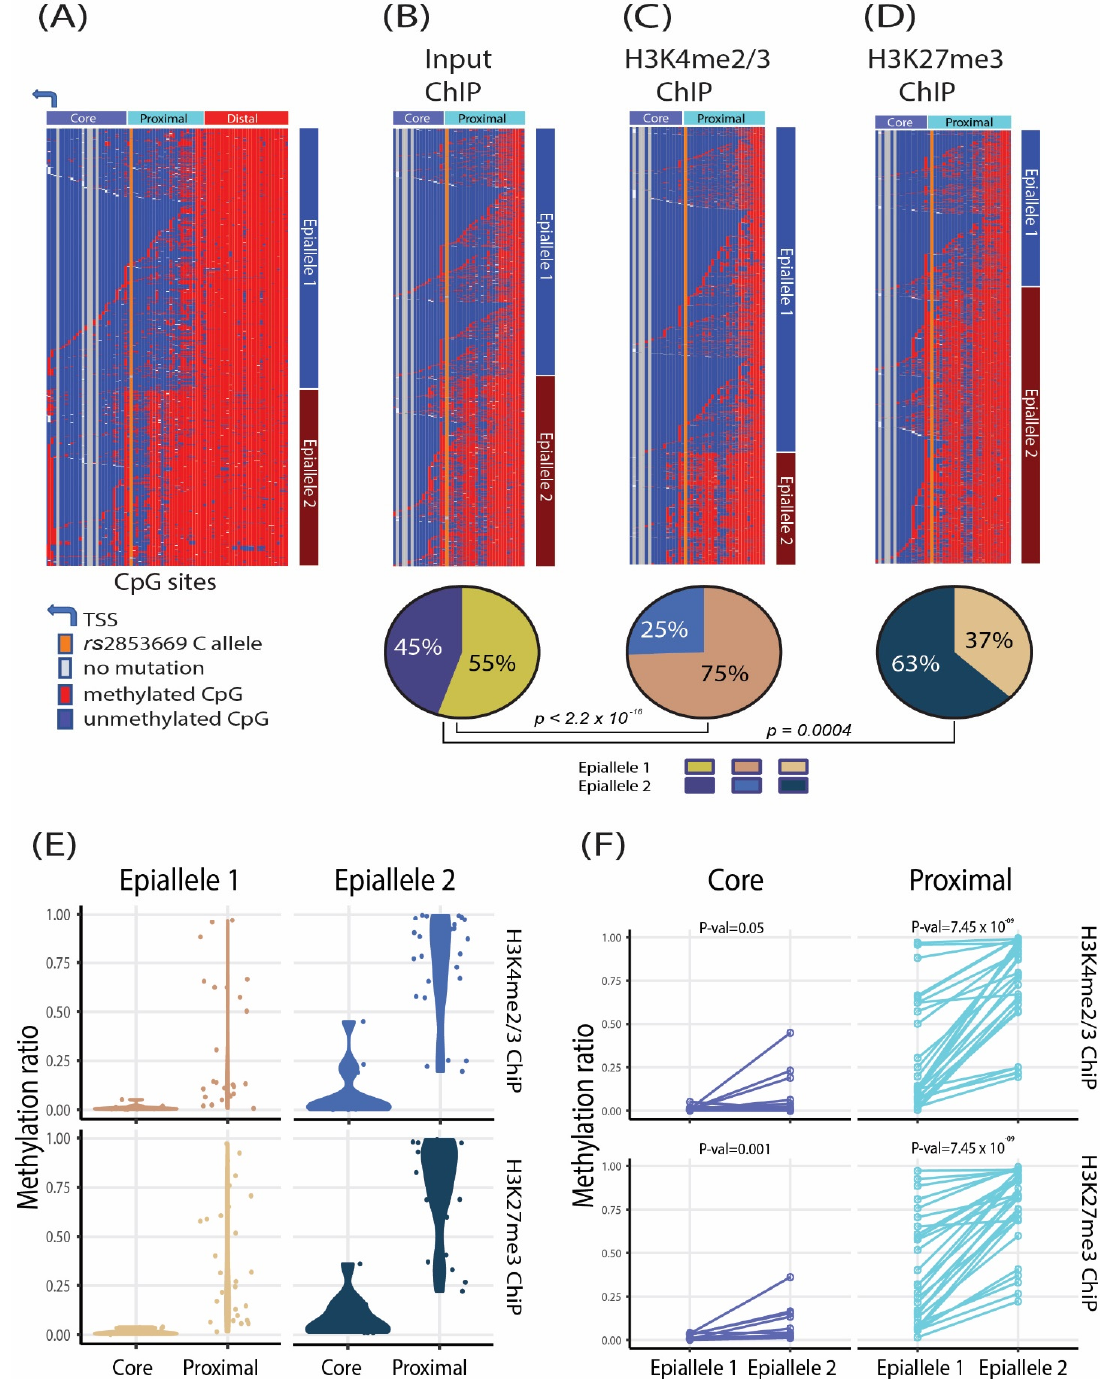
Figure 3. The mono-allelically expressing wild-type NCI–H2122 cancer cell line shows distinct allele–specific TERT promoter methylation patterns . ( A ) Methylation status of each CpG island per read in the TERT promoter (chr5:1,295,135–1,295,824) of wild–type NCI–H2122 is shown. The methylation status of the reads was clustered into two epialleles based on the breadth and depth of methylation. ( B – D ) Classification of epiallele 1 (less methylated) and epiallele 2 (more methylated) in NCI-H2122 promoters for ( B ) ChIP input sample DNA, ( C ) DNA enriched in the active histone mark H3K4me2/3 ChIP, and ( D ) DNA enriched in the repressive histone mark H3K27me3 ChIP. ChIP DNA was bisulfite converted, followed by the TERT promoter high-throughput targeted amplicon sequencing. Proportions of the read classified as epialleles 1 and 2 are shown as